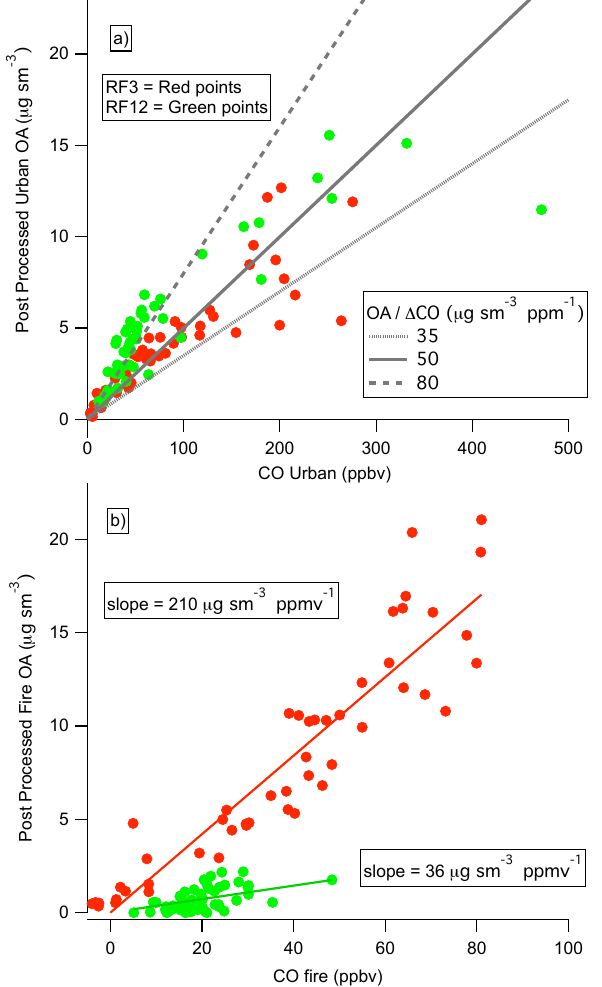
Fig. 10. Scatter plots of urban/regional OA vs. urban CO and fire- associated OA vs. fire-associated CO are shown in parts a) and b) respectively. Points are colored by flight with RF3 as red points and RF12 as green points. CO data comes from the Crounse et al. (2009) analysis. Lines of different slopes in part a) are intended to guide the eye.